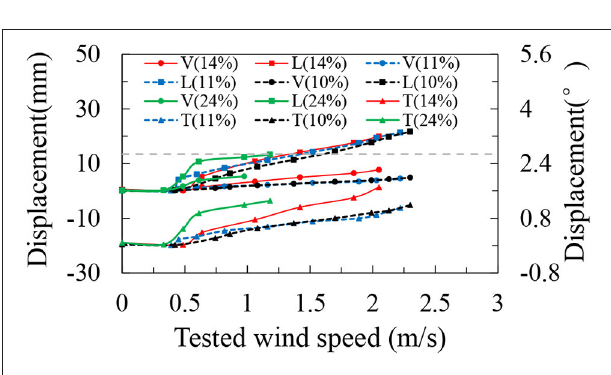
FIGURE 20 | Peak responses under different turbulence